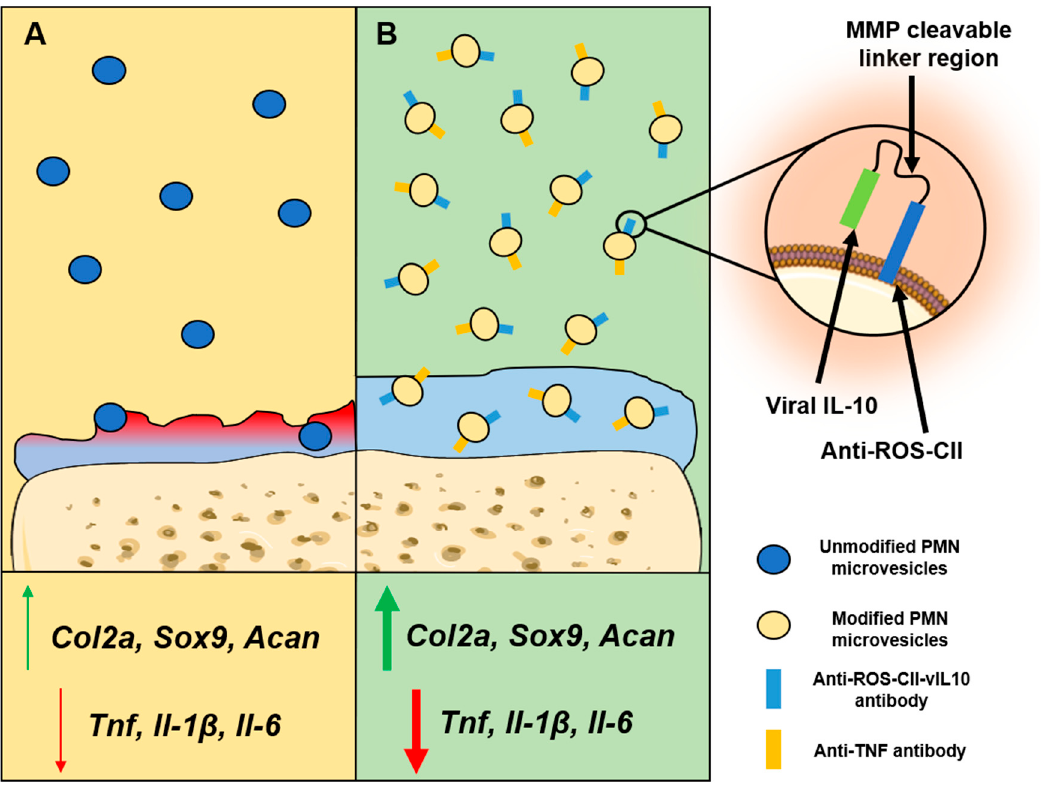
Figure 2. Therapeutic e ff ects of polymorphonuclear-cell-derived extracellular vesicles. ( A ) Unmodified polymorphonuclear-cell-derived extracellular vesicles (PMN-EVs) administered to collagen-induced arthritis (CIA) mice are reported to exert anti-arthritic e ff ects. PMN-EVs have been observed to penetrate cartilage where they can interact directly with chondrocytes. Upon cartilage infiltration, unmodified PMN-EVs inhibit the expression of genes responsible for pro-inflammatory cytokine production ( Tnf , Il-1 β , Il-6 ) and induce genes associated with cartilage anabolism ( Col2a , Sox9 , Acan ). However, because such EVs lack any specific tools for homing to the injured joint, their e ff ects are limited. ( B ) PMN-EVs modified to express antibodies targeting damaged type II collagen (anti-ROS-CII), found in arthritic but not healthy joints, are engineered to tra ffi c into arthritic joints specifically. Using a variant of anti-ROS-CII, bound to viral IL-10 via a matrix metalloproteinase cleavable linker region (anti-ROS-CII-vIL-10), EVs were able to release an anti-inflammatory payload upon arrival to the injured joint. PMN-EVs co-engineered to express both anti-ROS-CII-vIL-10 and anti-TNF antibodies were shown to greatly reduce pro-inflammatory cytokine gene expression and enhance cartilage anabolism; to the extent whereby CIA joints treated with modified PMN-EVs were similar to healthy joints based on gross architectural appearance [151,154] .